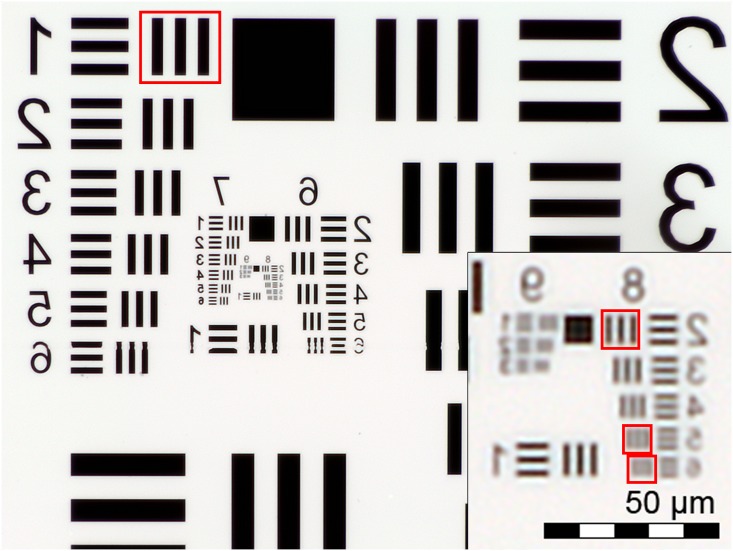
US Air Force 1951 three-bar resolution test chart.Image of standard 1951 USAF resolution target, captured with the point-of-care microscope. Due to the reversed camera lens the original image appears reversed horizontally.